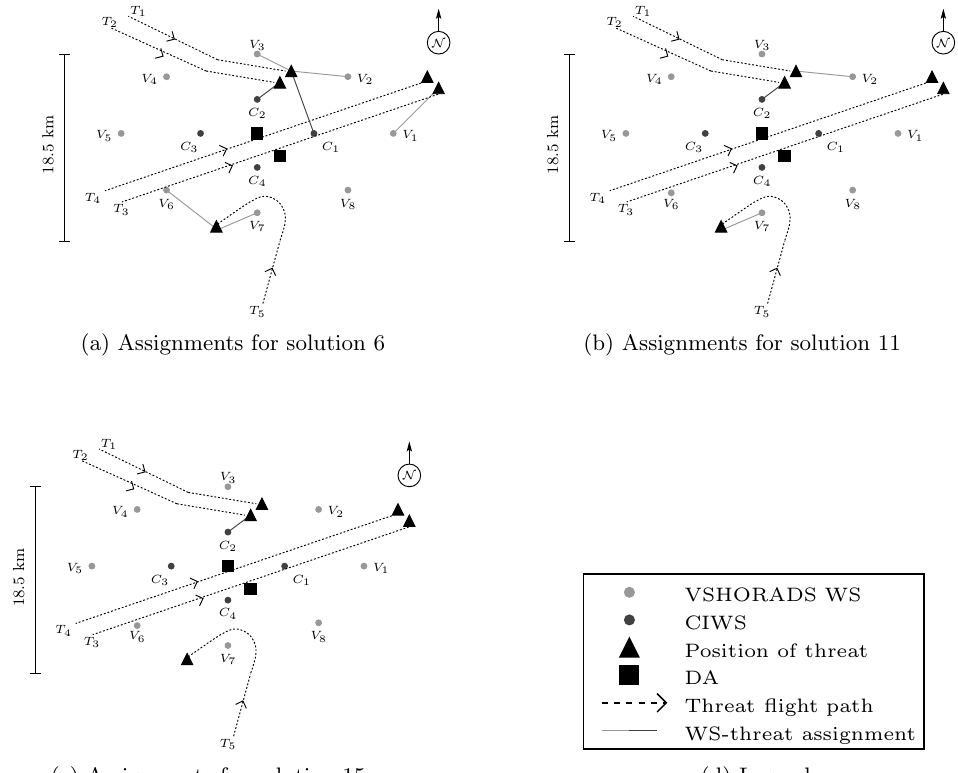
Figure 5: Top-view graphical illustration of the assignment of WSs to threats obtained by means of the NSGA II for Solutions 6, 11 and 15, respectively, at stage t